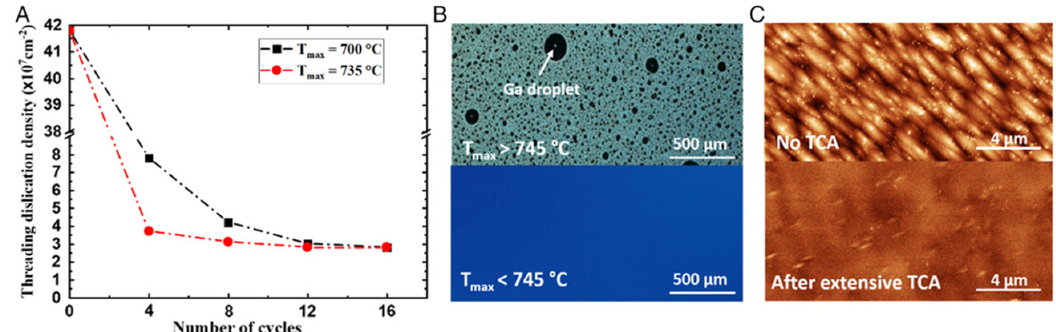
Figure 14. ( A ) Dependence of the threading dislocation density (TDD) of GaAs-on-Si template on the number of thermal cycle annealing (TCA) cycles. ( B ) Nomarski contrast images of the GaAs surface after annealing above and below 745 °C pyrometry temperature. ( C ) Electron channeling contrast imaging (ECCI) images of the GaAs surface without TCA (top) and with 16 cycles of TCA (bottom). Reprinted from Reference [206] © 2020 The authors, under CC BY.